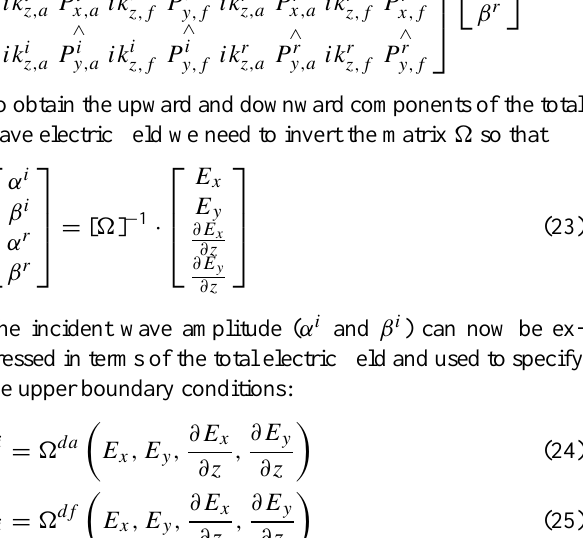
to be 1000 km in altitude with a uniform grid spacing of 2 km. The composition of the atmosphere and ionosphere were calculated from the thermosphere model based on satel- lite mass spectrometer and ground-based incoherent scatter data (MSISE90), (Hedin, 1991) and the International Ref- erence Ionosphere (IRI-95) models. The International Ge- omagnetic Reference Field (IGRF-95) was used to provide values for B 0 . Data for the collision frequencies below 80 km were extrapolated to the ground using the expressions in Ap- pendix A. The eigenvectors, P , in Eq. ( 16) were found using the NAG routine F02GBF, while the roots of Eq. (14) were computed using the NAG routine